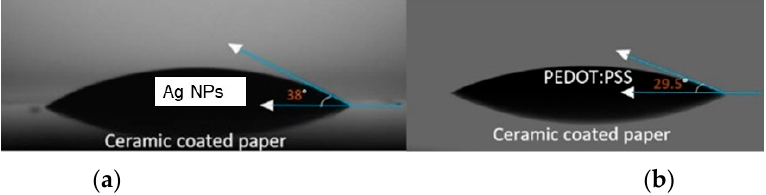
Figure 4. Images of the ( a ) AgNP and ( b ) PEDOT:PSS ink droplets on ceramic coated paper after achieving equilibrium during the contact angle measurements.